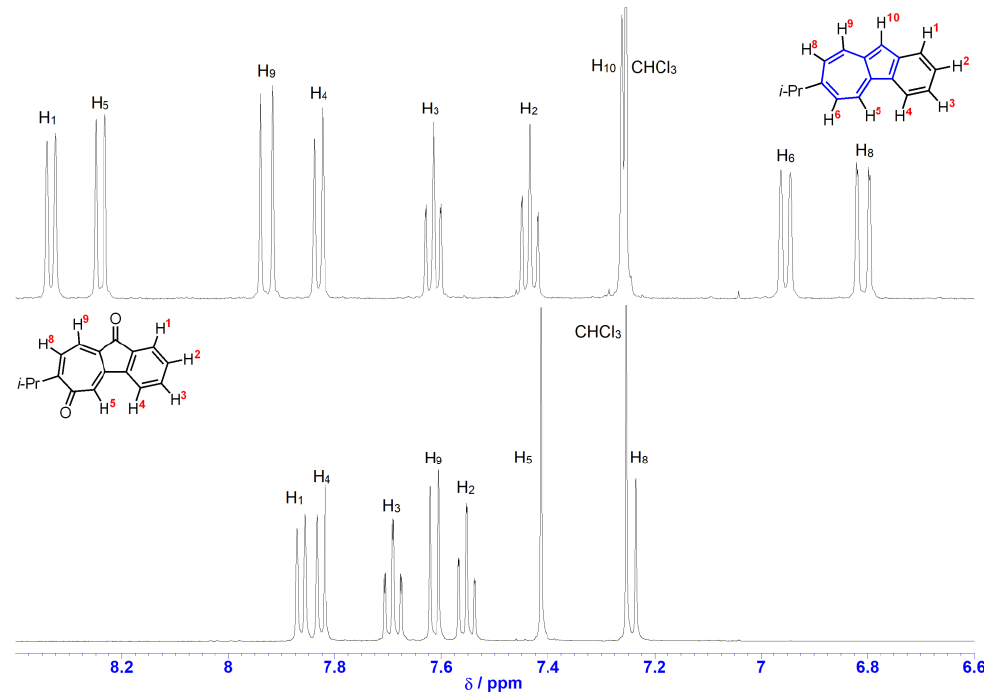
Figure 3. 1 H NMR spectra of 1b (top) and 2b (bottom) in CDCl 3 (500 MHz).